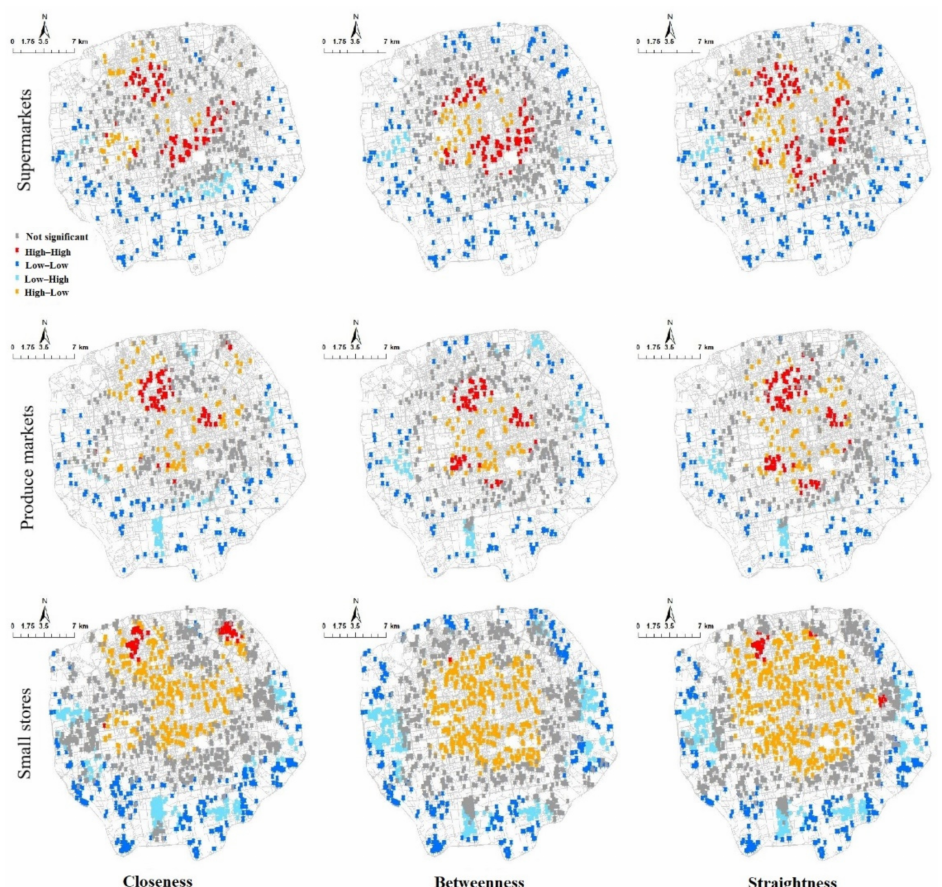
Figure 5. Results of bivariate LISA analysis for the three types of food retail outlets. The red (High– High) and blue (Low–Low) indicate a positive spatial correlation between the road network centrality and food retail outlets. The green (Low–High) areas had low road network centrality and densely distributed food retail outlets, whereas yellow (High–Low) areas had high road network centrality and sparsely distributed food retail outlets, showing spatially incompatible relationships. And gray (Not significant) indicate there is no significant relationship between the two